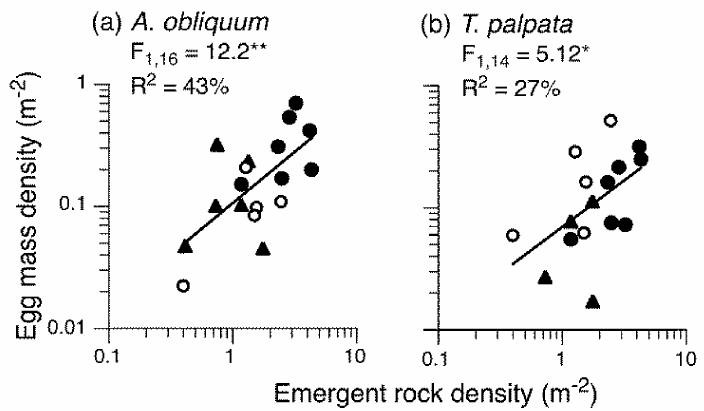
Figure 4. Relationships between the densities of egg masses and emergent rocks in different riffles for two species of caddisfly from different families, ( a ) Apsilochorema obliquum (Hydrobiosidae) and ( b ) Tasimia palpata (Tasimiidae). In each riffle, every emergent rock ≥ 5 cm (b-axis) and in ≥ 5 cm of water was examined for egg masses. Statistically significant relationships are indicated by regression lines and summary statistics. Data were log-transformed before analyses. Different symbols indicate riffles in different rivers, which were close together in Victoria, Australia. Riffles from multiple rivers were required to ensure a wide range of densities. Riffles with no egg masses were excluded from the analyses; preliminary statistical tests indicated that the nature of the relationships did not differ between rivers